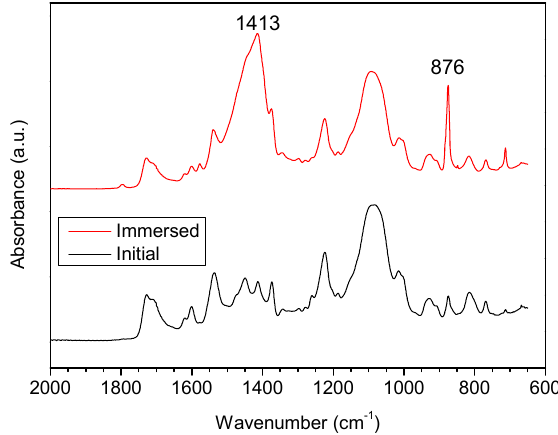
Figure 9. FTIR spectra of PU-Si0 before and after immersion in seawater.